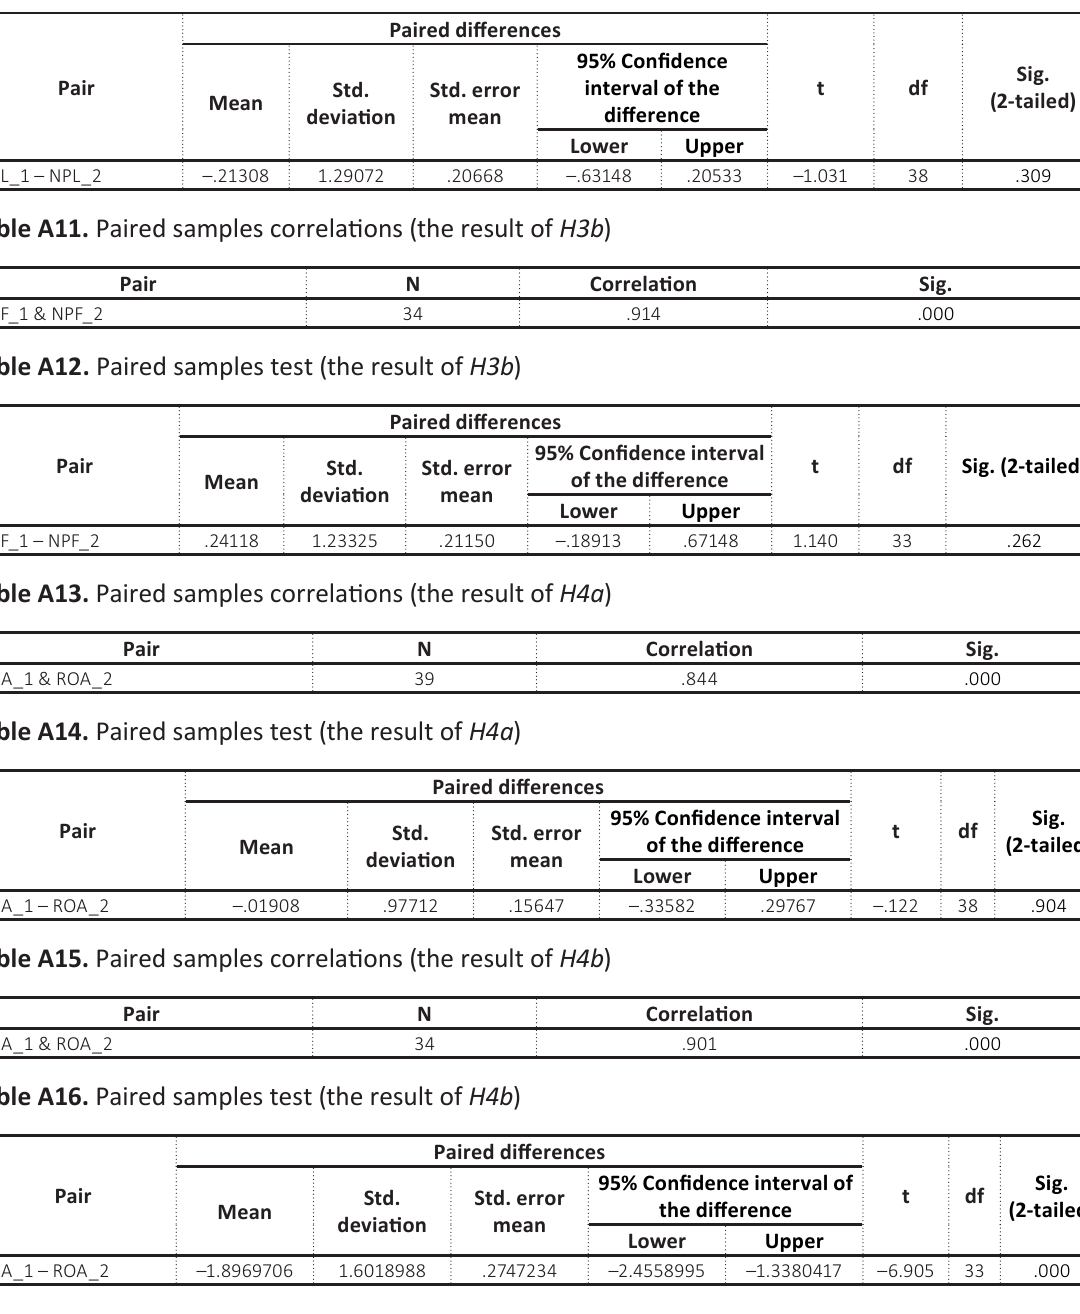
Table A10. Paired samples test (the result of H3a )